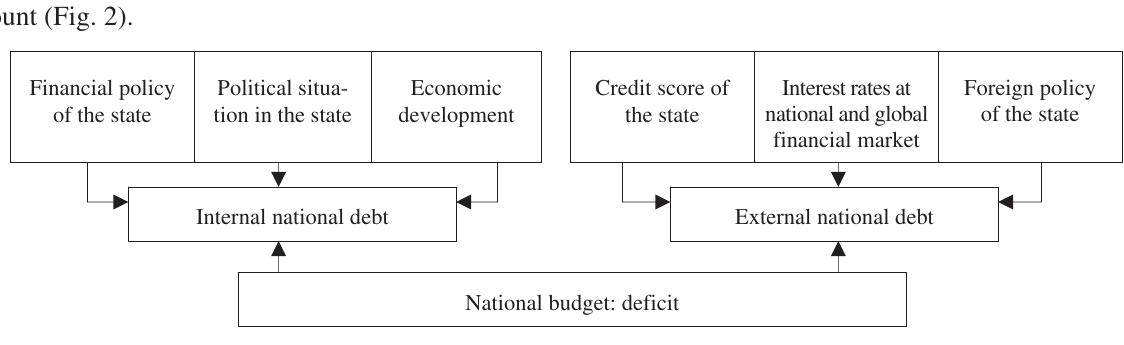
Fig. 2. Main factors of influence on external and internal national debts